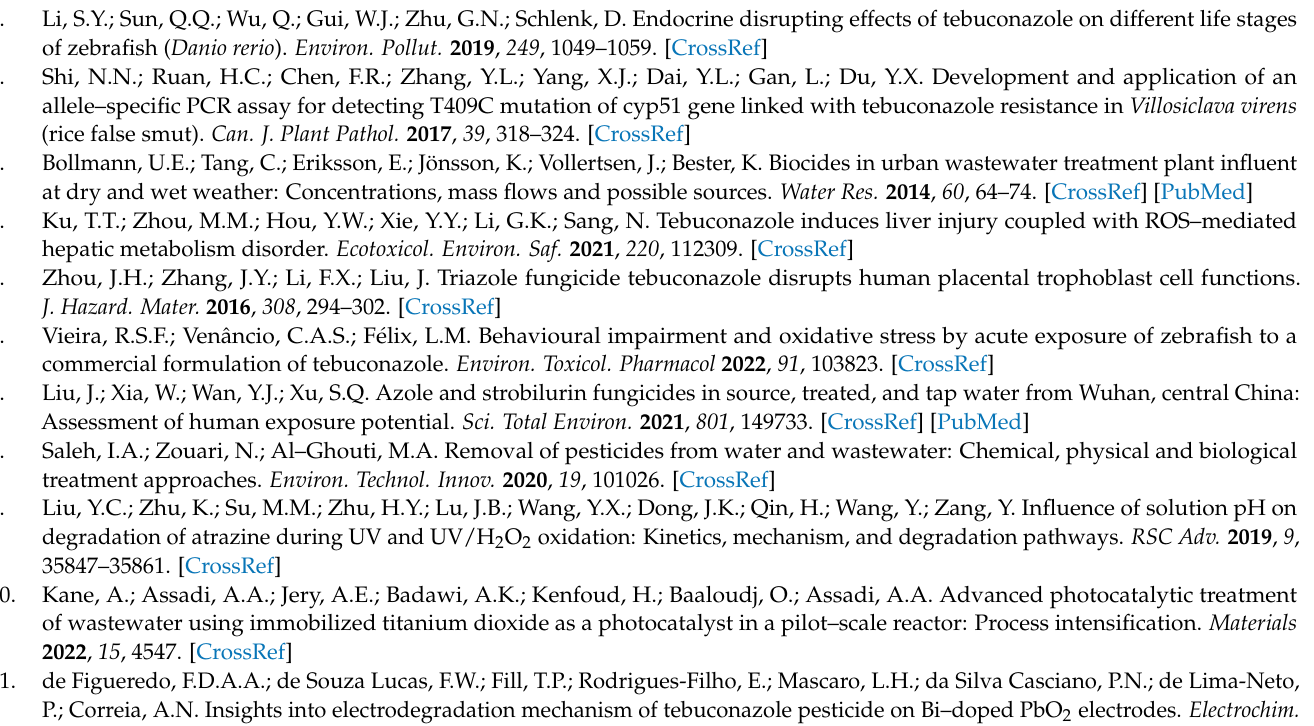
Figure S1: Adsorption capacity of WHCBC with different modification ratios; Figure S2: Adsorption capacity of WHCBC with different pyrolysis temperatures; Figure S3: Adsorption–desorption and pore size distribution of the two biochars: (a) surface area comparison between WHBC and WHCBC; (b) pore size comparison between WHBC and WHCBC; Figure S4: Zeta potential of WHCBC at different solution pH conditions; Figure S5: The leaching concentrations of Ca of WHCBC at different solution pH